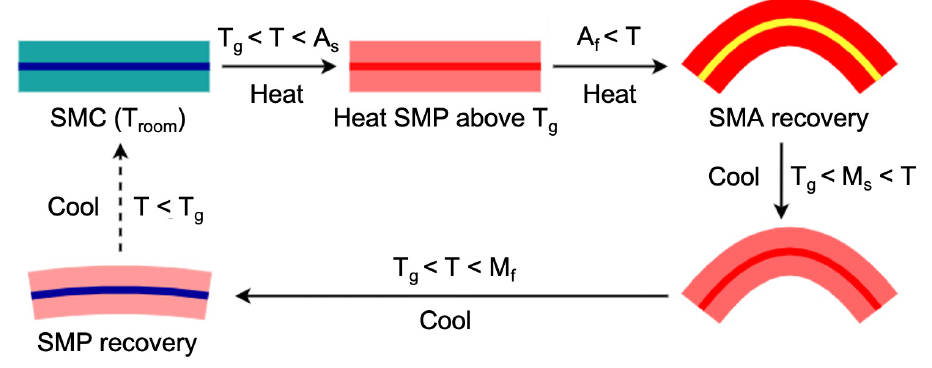
Figure 2. Schematic diagram of periodic actuation of the SMC obtained by undergoing a sequence of phase transformations due to temperature variation and the relative stiffness of the SMA and